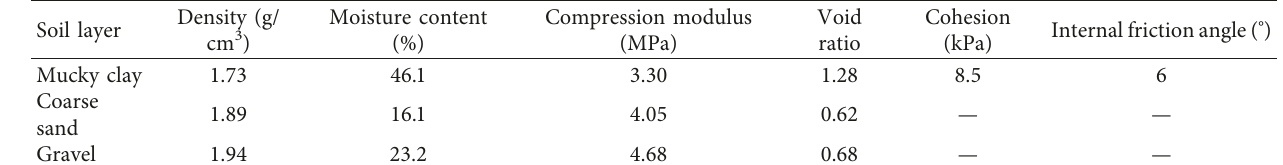
Table 4: Model soil